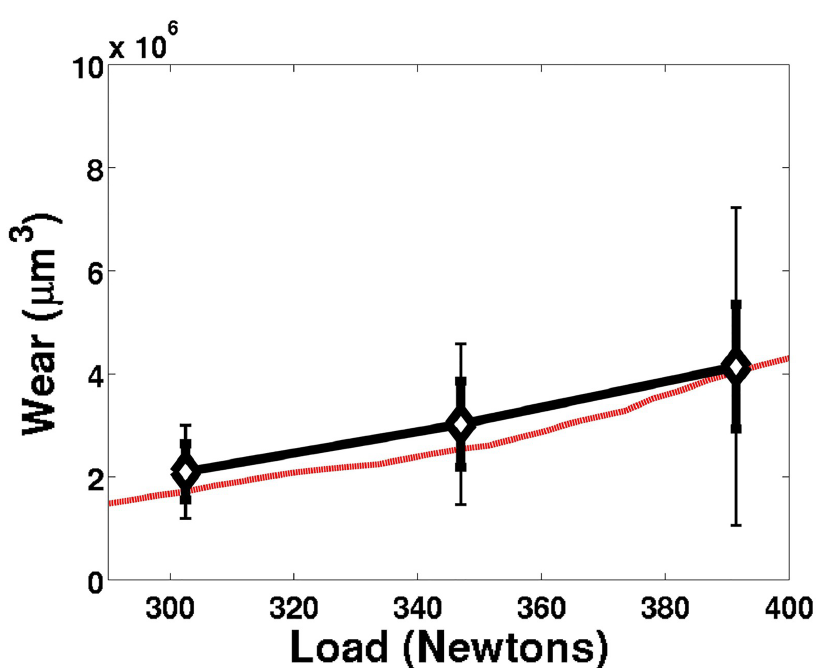
Fig 11. Wear ( μ m 3 ) experimental data and matching simulation results as a function of load (Newtons). Diamondsrepresent the experimental averagetotal wear, whileerror bars representthe average (thick error bars) and maximum (thin error bars) experimental variationof the total wear observedbetweenall six samples (two repeatingtests with three ball bearingseach).